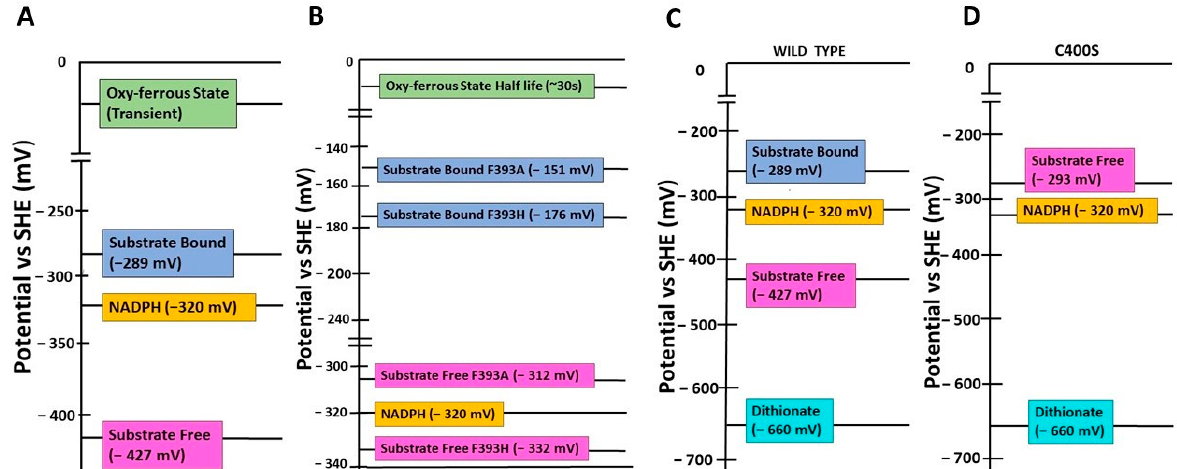
Figure 3. Comparison of heme redox potentials of wildtype and variants of P450 BM3 . Redox potentials (mentioned in brackets) of NADPH, substrate-free and bound heme groups, and the oxy-ferrous states of ( A ) wild-type and ( B ) the variants F393A and F393H of P450 BM3 . Redox potentials in mV (mentioned in brackets) of NADPH, dithionite, and substrate-free heme groups of ( C ) wild-type and ( D ) the variant C400S of P450 BM3 . SHE: Standard Hydrogen Electrode. There have been studies on the roles of highly conserved F393 in P450 BM3 on thermo- product, and so on [10,20]. F393 is present within the heme-binding motif of P450 BM3 , which is positioned close to the C400, which coordinates the iron of heme and is located near to heme plane (Figure 1A). Variants of P450 BM3 are generated by substituting F393 with an equivalent residue tyrosine and the non-equivalent residues histidine and alanine.